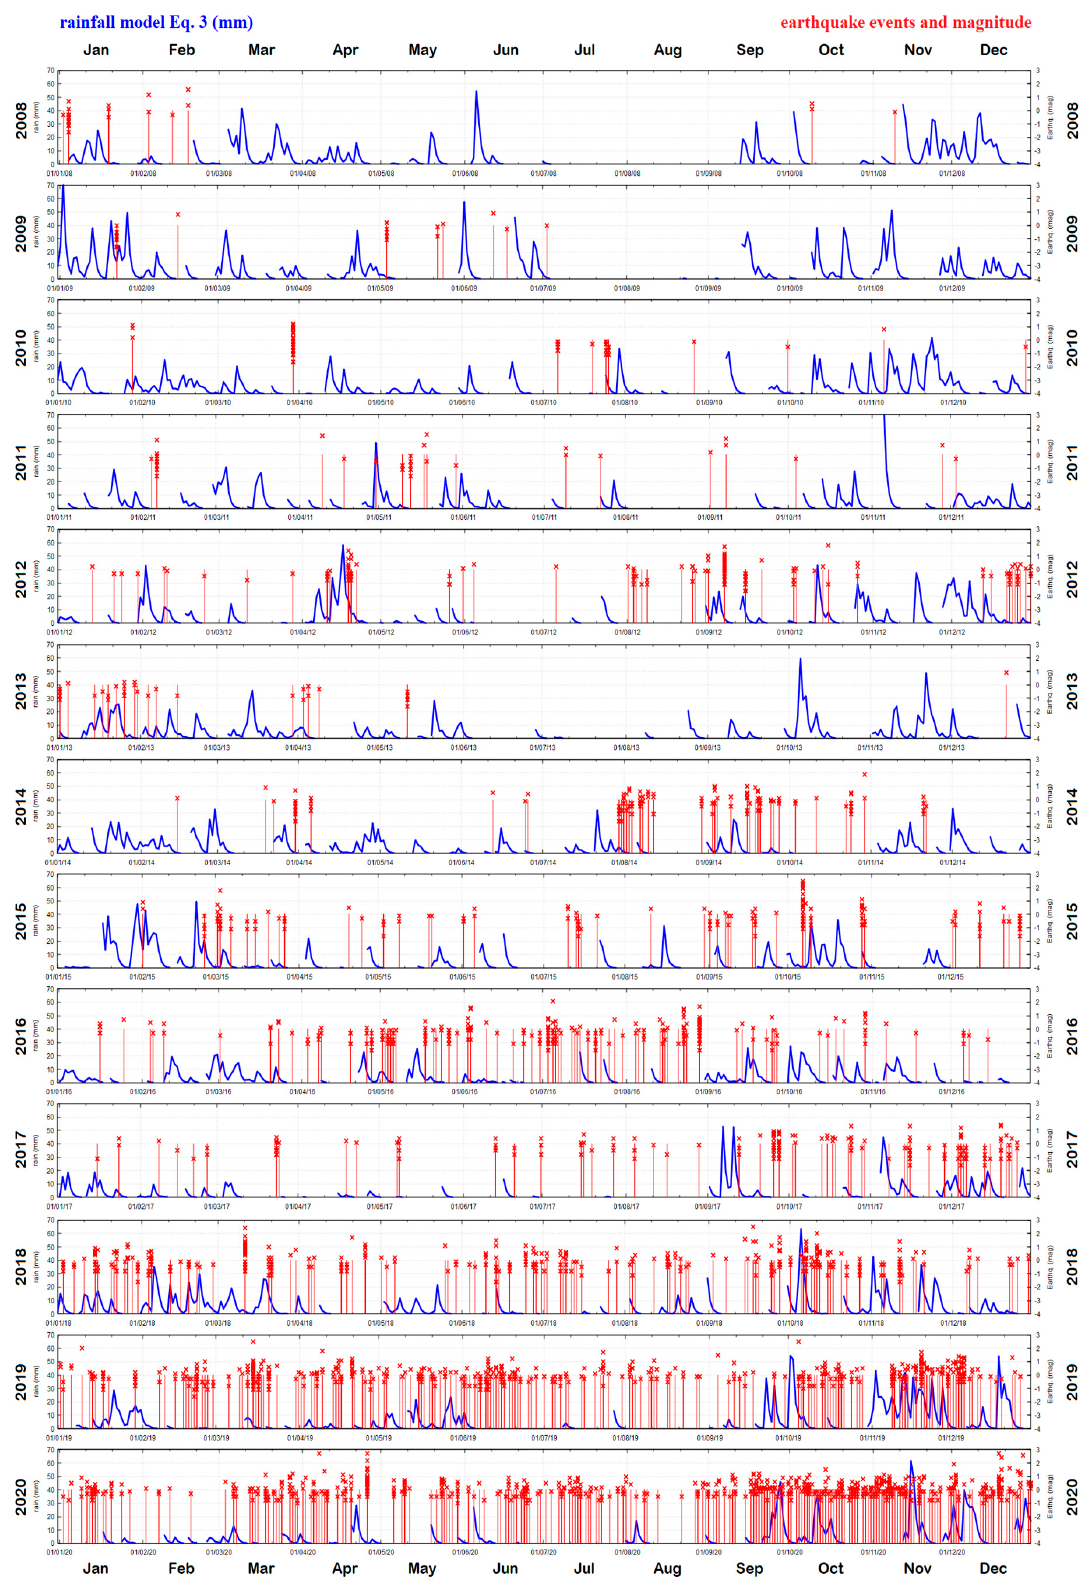
Figure 2. Scenario #1: R = 0.2 mm and τ = 1 day. Comparison between the empirical water stress-function (Equation (3)) estimated with the rainfall record of the Meteorological Observatory at San Marcellino in Naples (blue) and the seismic events at the Phlegraean Fields from 2008 to 2020 (red). Each panel covers one year. See Table 2.